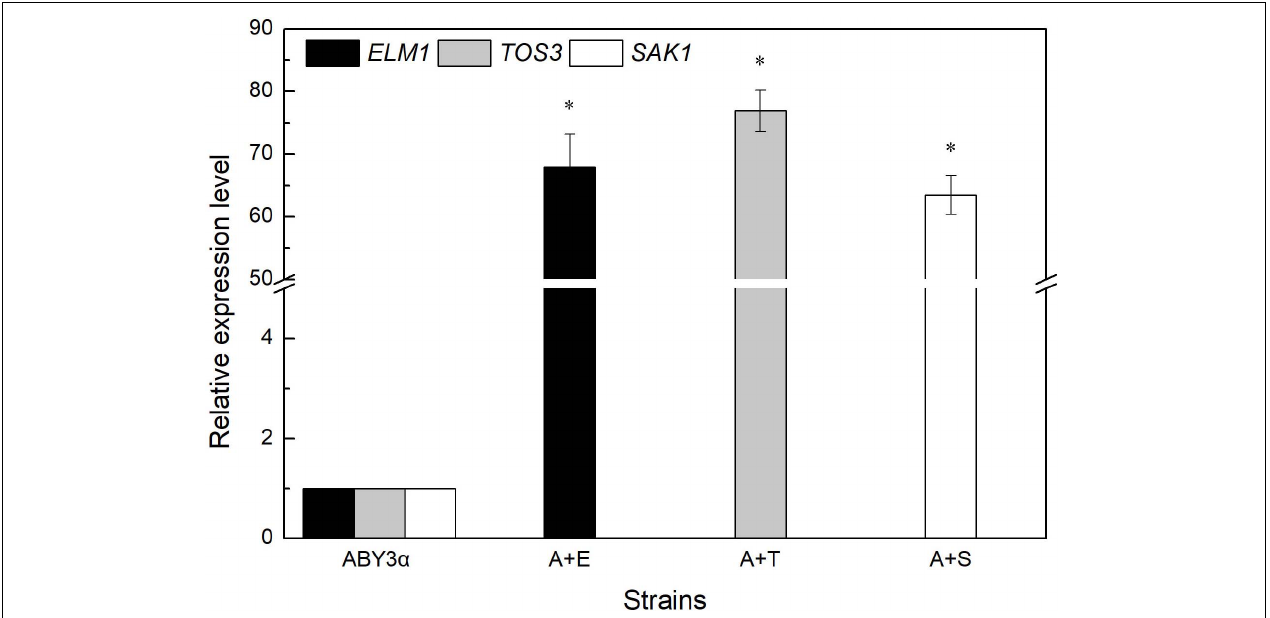
FIGURE 1 | mRNA level of the overexpressed genes. The expression level of ELM1 in the strain A+E, TOS3 in the strain A+T, and SAK1 in the strain A+S was tested using qRT-PCR. The cells were sampled from YEPD medium at 16 h. ABY3 α : the parental strain; A+E: the transformant carrying ELM1 overexpression; A+T: the transformant carrying TOS3 overexpression; A+S: the transformant carrying SAK1 overexpression. Significant differences of the transformants to the parental strain were confirmed at * p < 0.05.